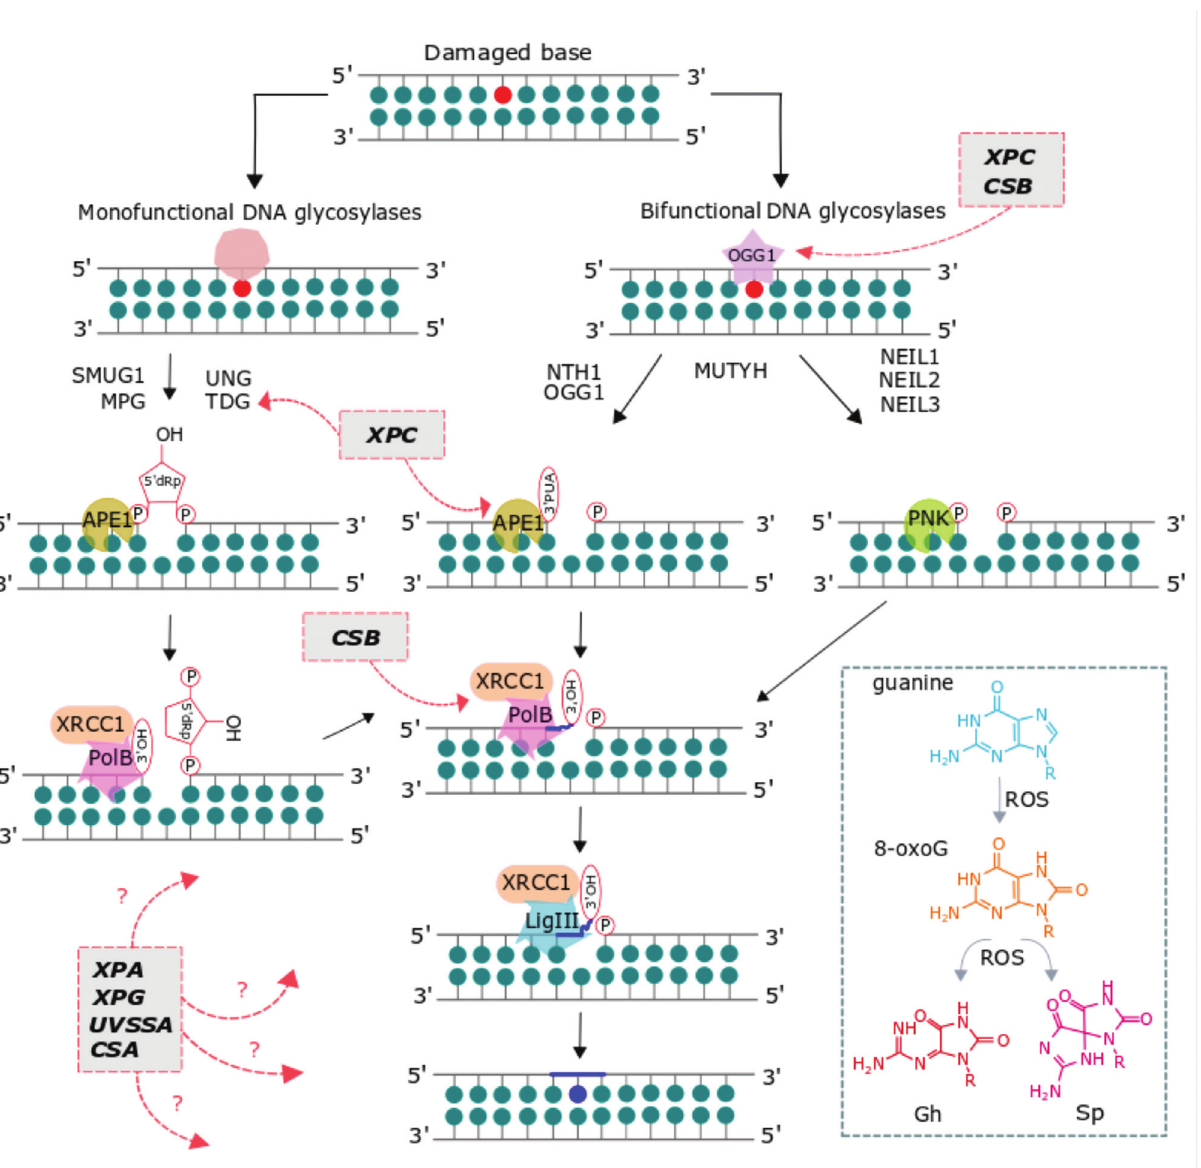
Figure 1 - Mono- and bi-functional DNA glycosylase-initiated short-patch base excision repair (BER) in mammalian cells. The process consists of these main steps: Excision of the base lesion, incision by an AP endonuclease, end processing, gap filling and ligation. Insert shows the common oxidative le- sions repaired by BER: 8-oxoguanine (8-oxoG), guanidinohydantoin (Gh), spiroiminodihydantoin (Sp). Grey boxes (red dashed outline) indicate the in- volvement of NER (XPA, XPC, XPG, CSA, CSB and UVSSA) proteins in